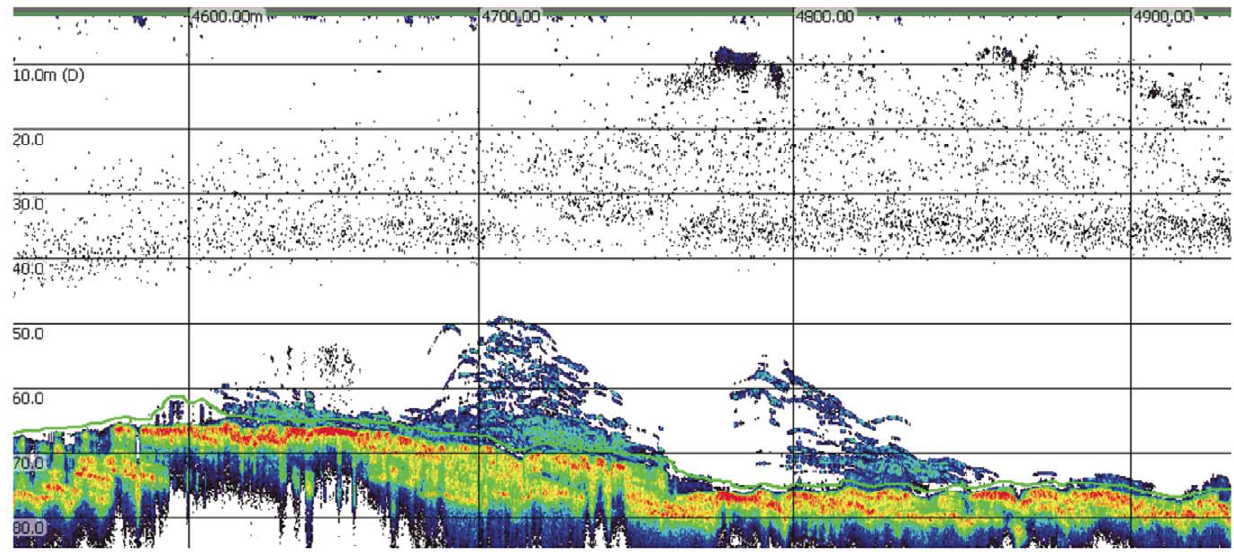
Figure 7. Echogram of cod spawning aggregation in the transitional habitat between boulder/lava field (left) and sand (right) on Lofstadarhraun off southwestern Iceland 16 April